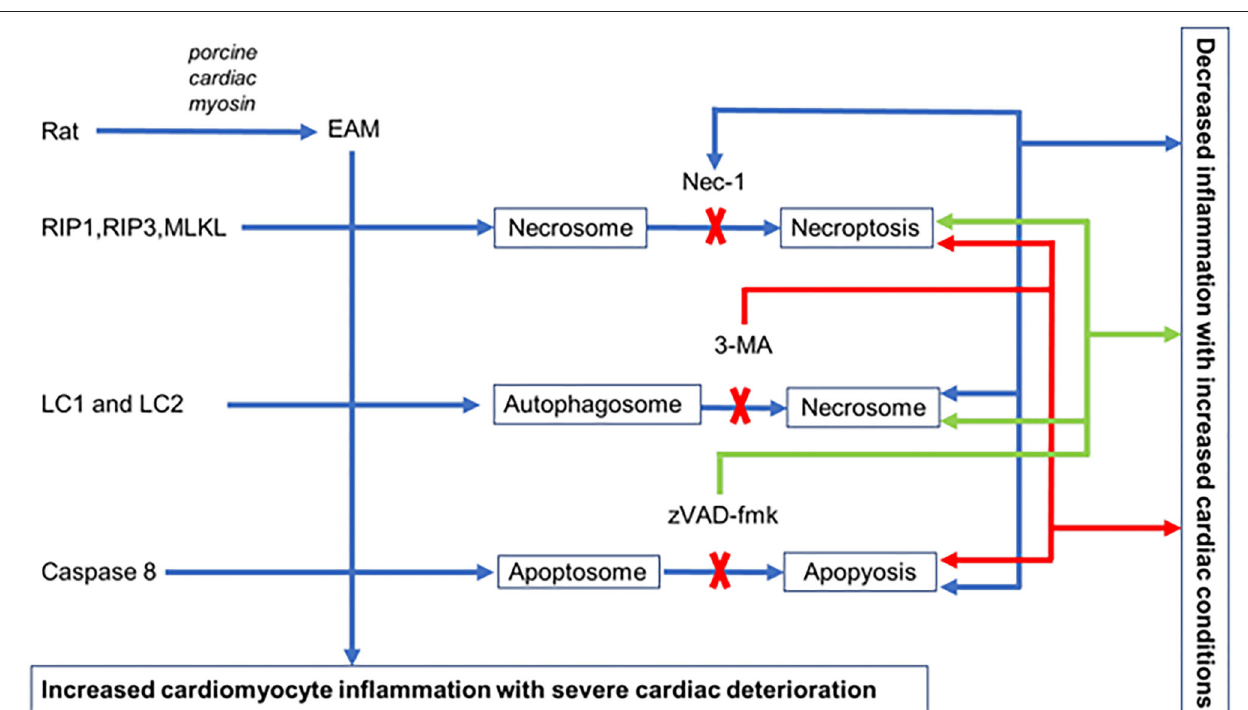
FIGURE 9 | Hypothetical illustration of cell death in EAM model. In EAM, all three processes of cell death take place, but when necroptosis is blocked by Nec-1, apoptosis increases but there is no effect on autophagy. When autophagy is blocked by 3-MA, both apoptosis and necroptosis are increased. When apoptosis is blocked by zVAD-fmk, it increases both necroptosis and